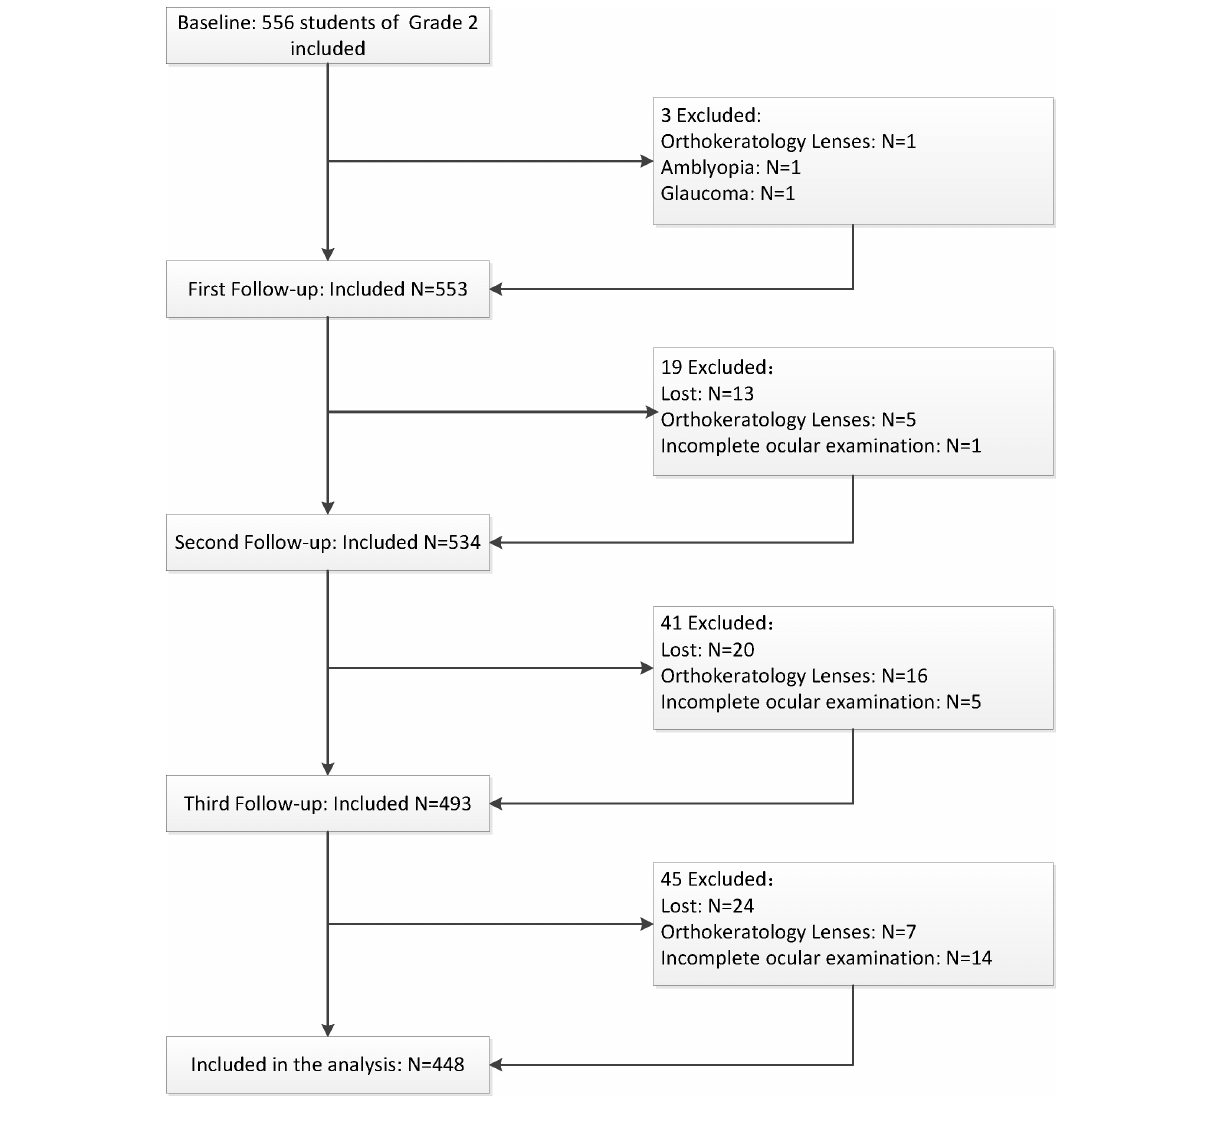
FIGURE 1 | Flow chart of the inclusion and exclusion of the study